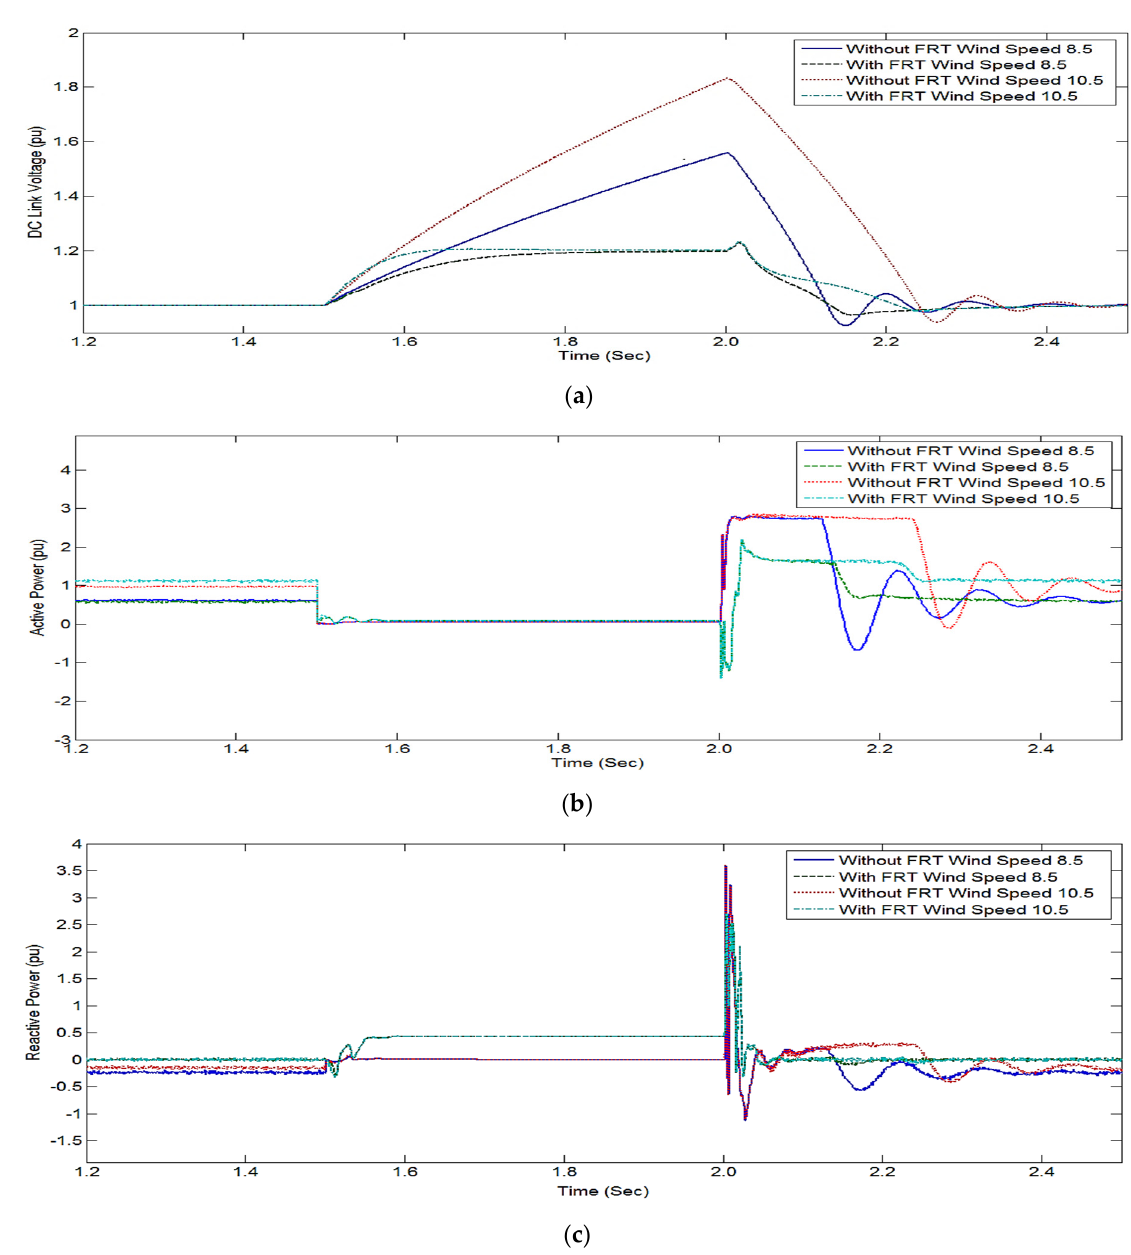
Figure 7. Behavior of WECS during symmetrical fault, with and without FRT control for 8.5 m/s and 10.5 m/s wind speeds: ( a ) dc-link Voltage, ( b ) Active Power supplied, ( c ) Reactive Power supplied by Generator.